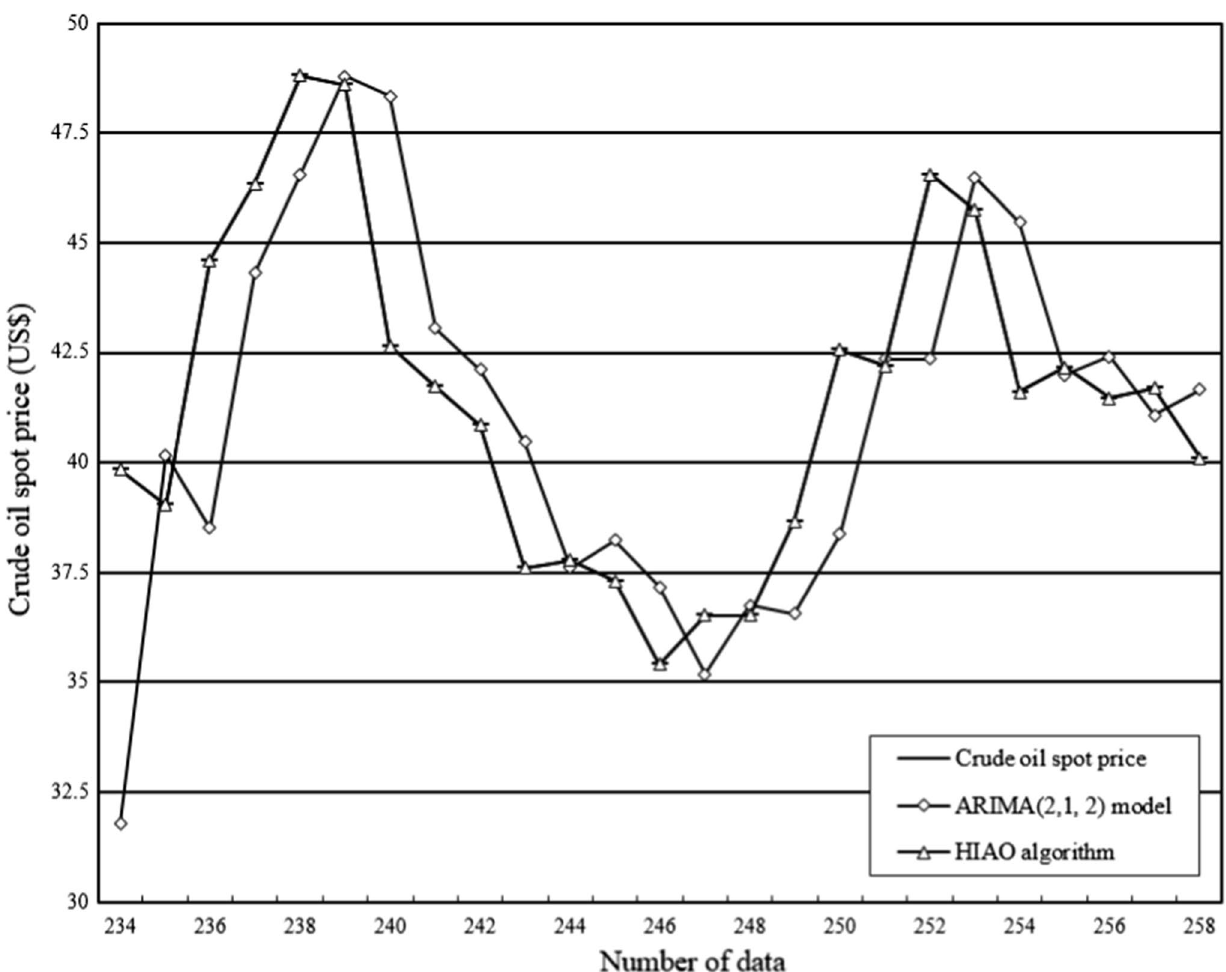
Fig. 3 The prediction results compared to the proposed HIAO algorithm and ARIMA (2, 1, 2) model for the crude oil spot price prediction